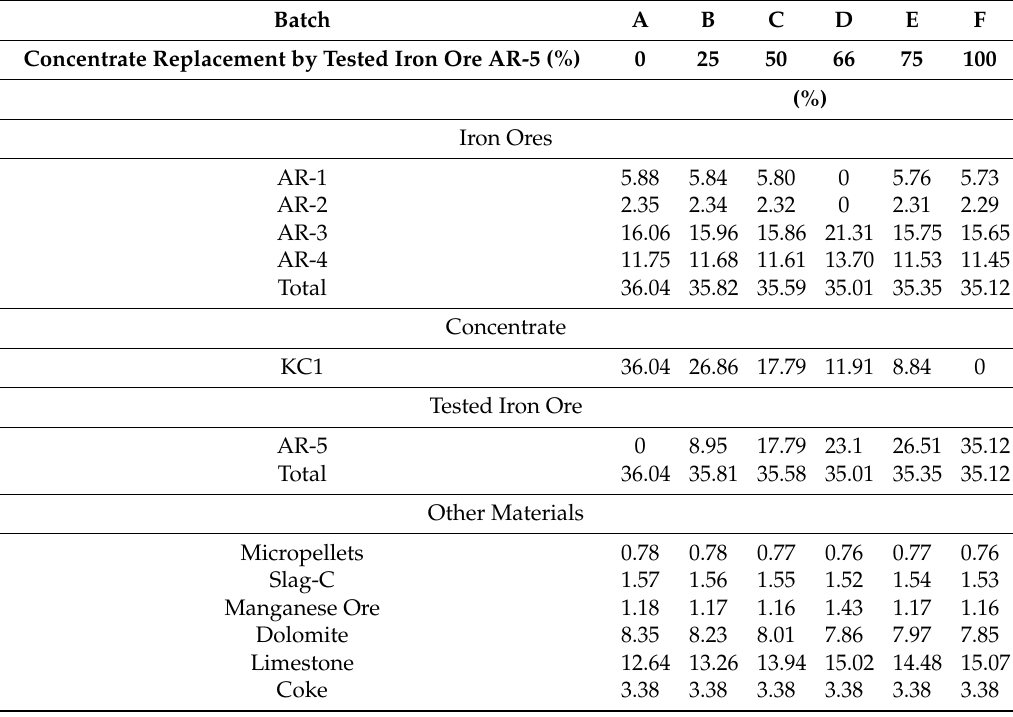
Table 5. The composition of individual experimental batches. Batch A B C D E